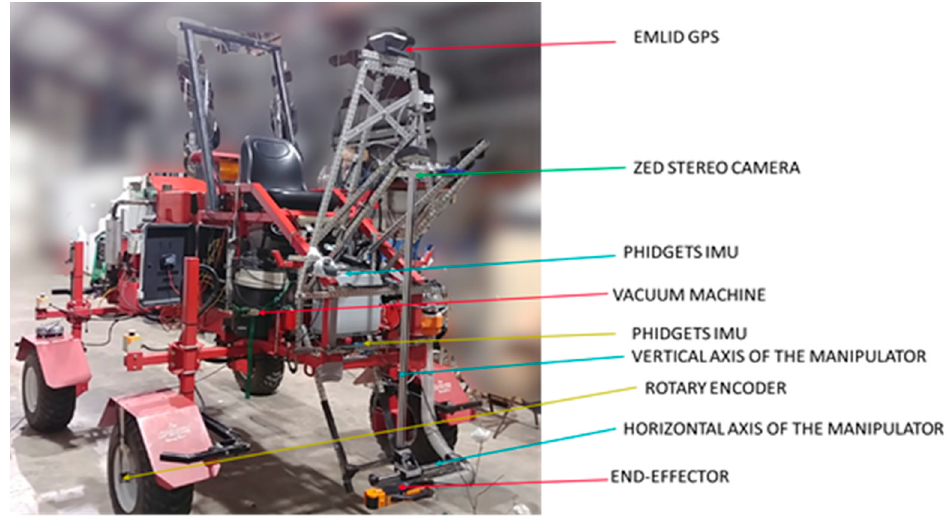
Figure 2. The robotic arm, vacuum, and sensors mounted on the red rover.